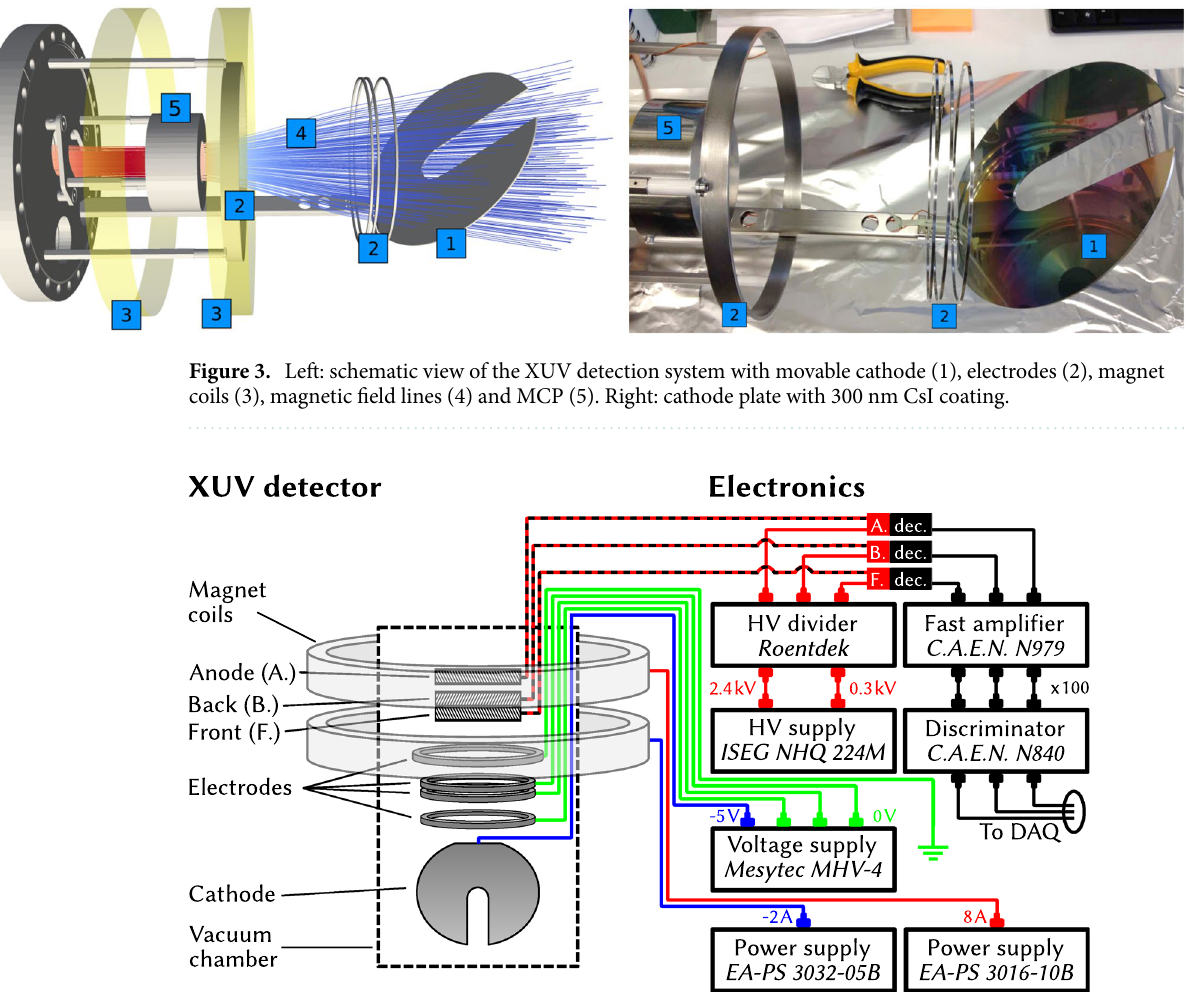
Figure 4. Interconnections of the XUV detection system with power supplies and front-end electronics of the data acquisition